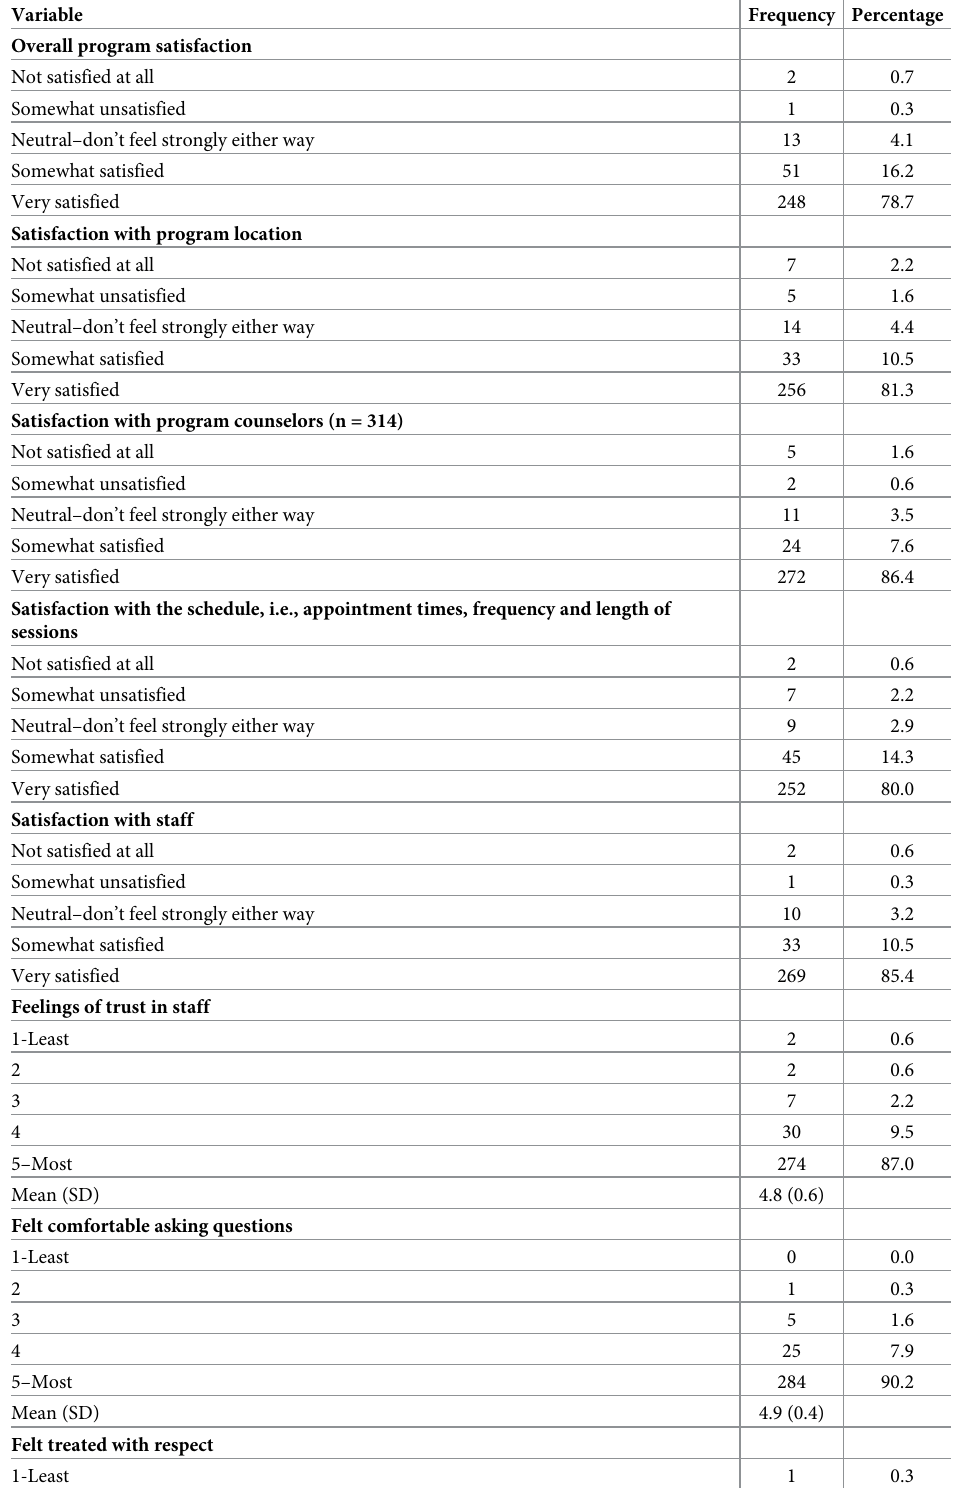
Table 3. Program satisfaction among